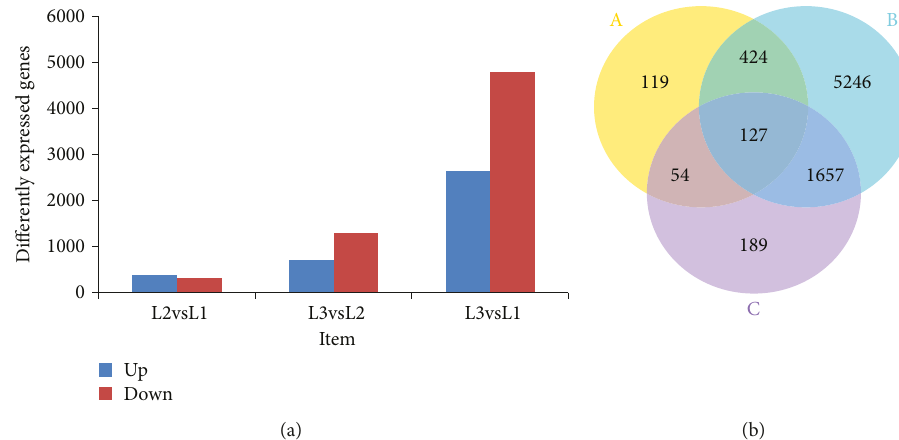
Figure 3: Distribution of di ff erentially expressed genes in walnut kernel at di ff erent developmental stages. (a) Number of di ff erentially expressed genes in di ff erent combinations. (b) Venndiagram of di ff erentially expressed genes in di ff erent combinations: A: L2vsL1; B: L3vsL1; and C: